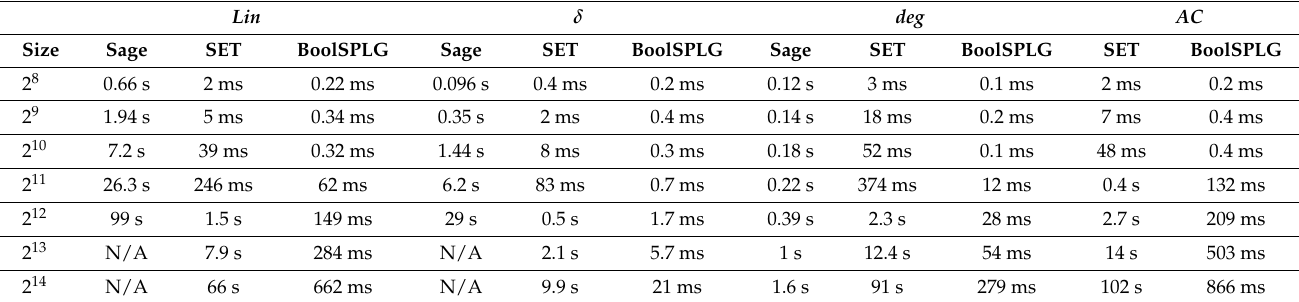
Table 7. Calculation times of BoolSPLG, Sage, and